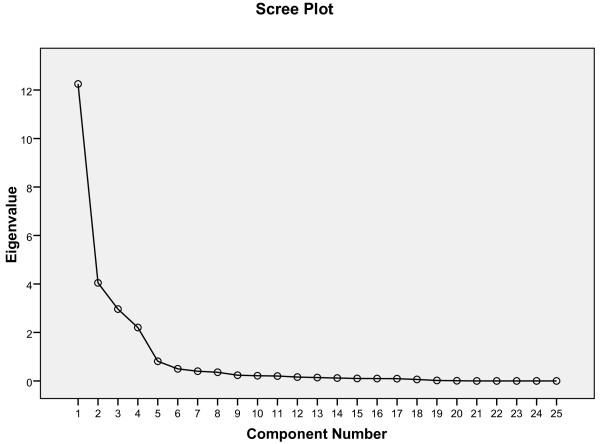
Scree Plot of the exploratory one-factor solution.